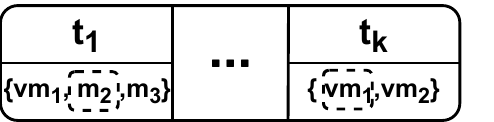
Figure 4. The particle structure. The dashed square is the selected